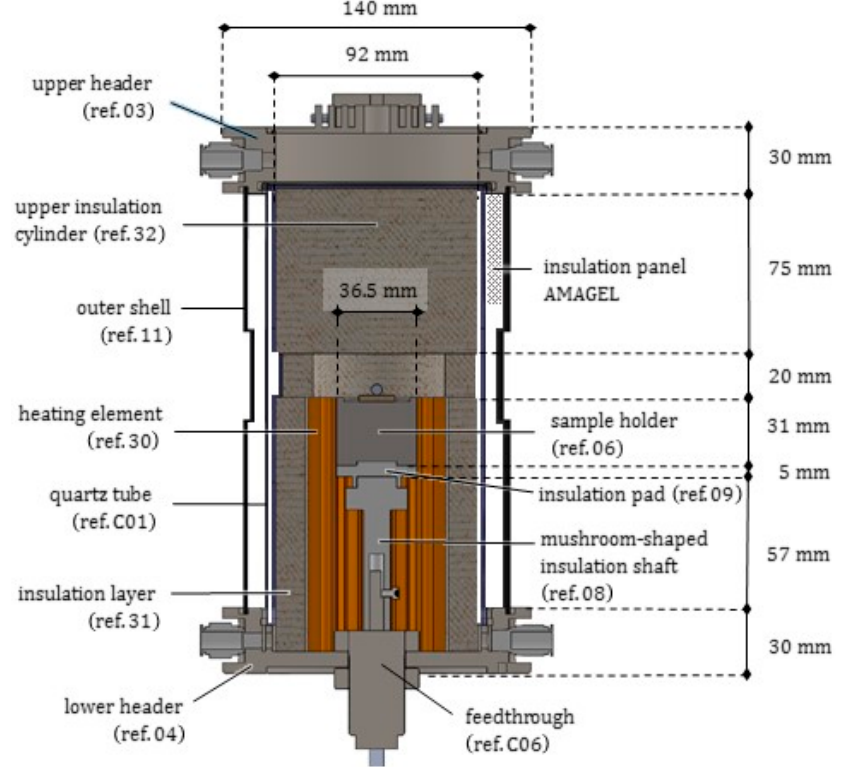
Figure 3. Longitudinal radial section of the furnace prototype. Main components and dimensions are indicated.